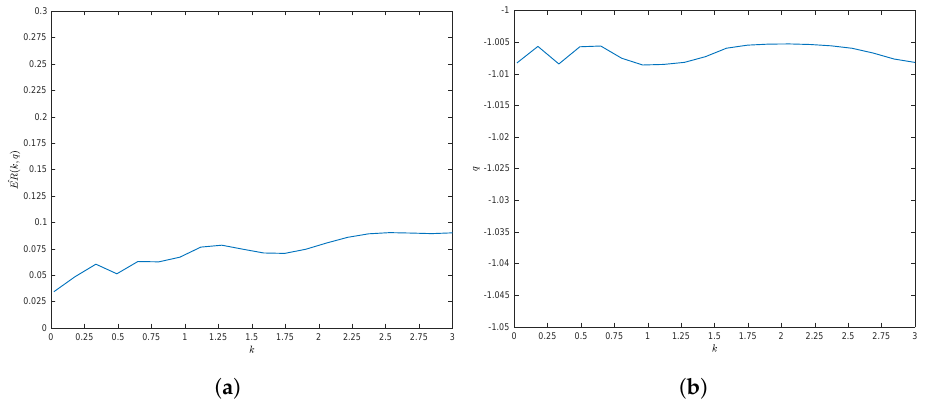
Figure 9. Optimal q parameter and Error ER ( k , q ) values: ( a ) ER ( k , q ∗ ) minimum value; ( b ) optimal q ∗